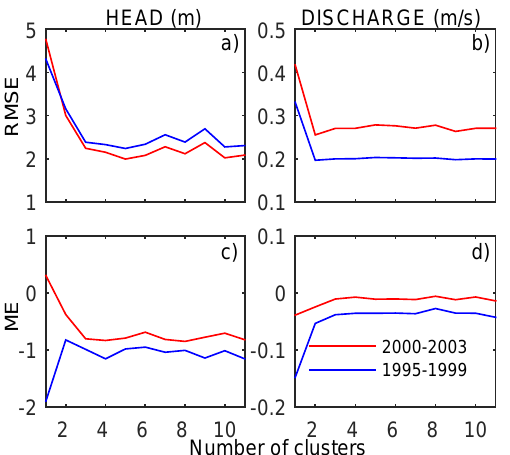
Figure 7. 2000–2003 calibration and 1995–1999 validation period performance statistics for the 11 hydrostratigraphic cluster models consisting of 1–11 clusters. The top row shows RMSE and the bot- tom row shows ME.